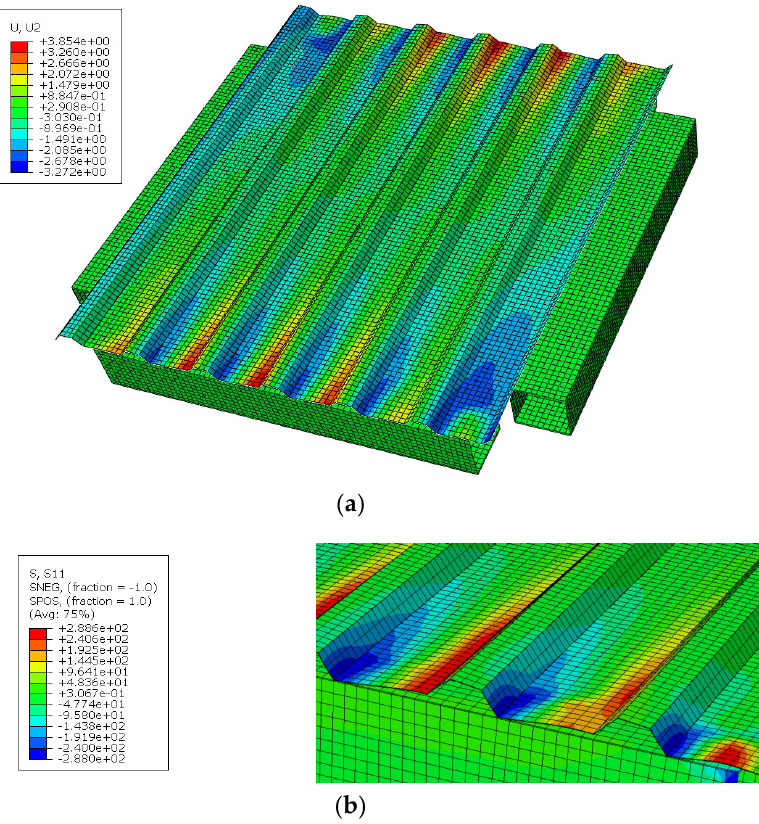
Figure 11. Selected results of the numerical analysis: ( a ) displacements in the direction perpendicular to the panel [mm]; ( b ) stresses in the direction perpendicular to the corrugation [MPa].